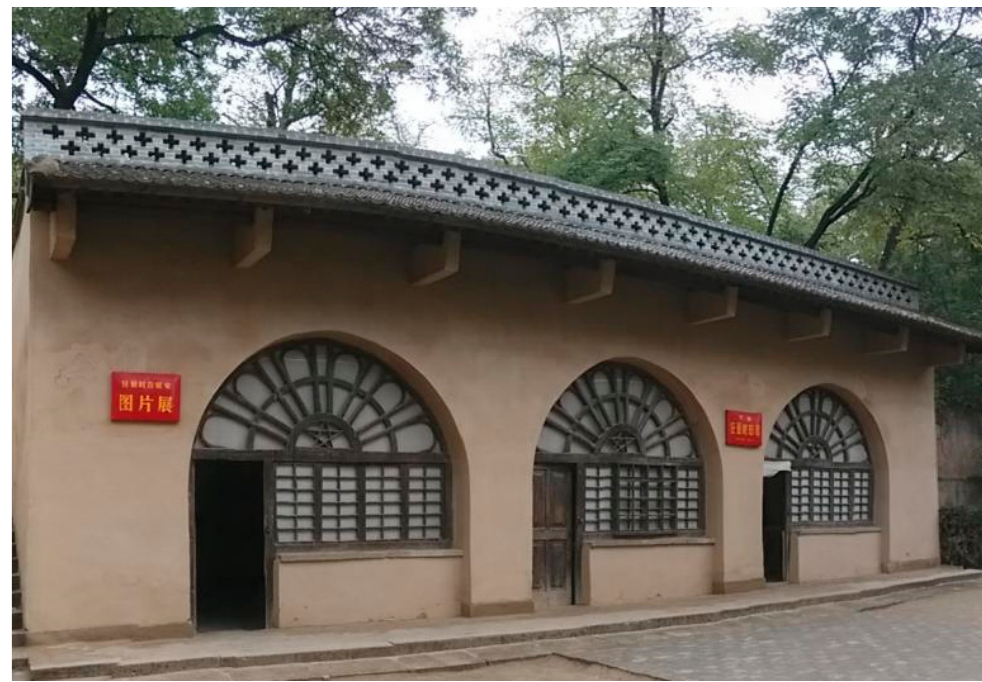
Figure 3. Real picture of the masonry cave dwelling.